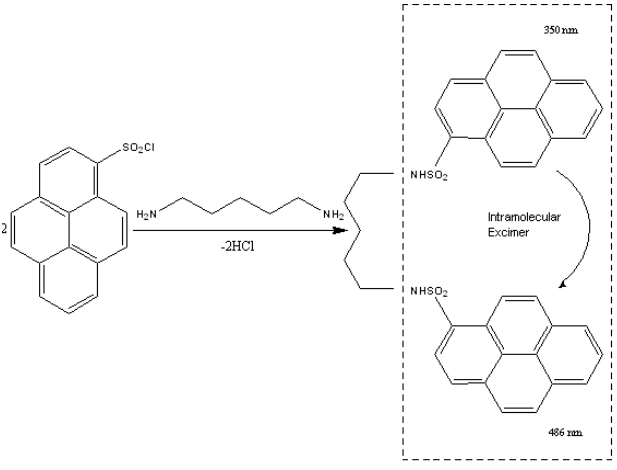
Figure 2. Intramolecular excimer-forming fluorescence derivatization of cadaverine with PSCl.